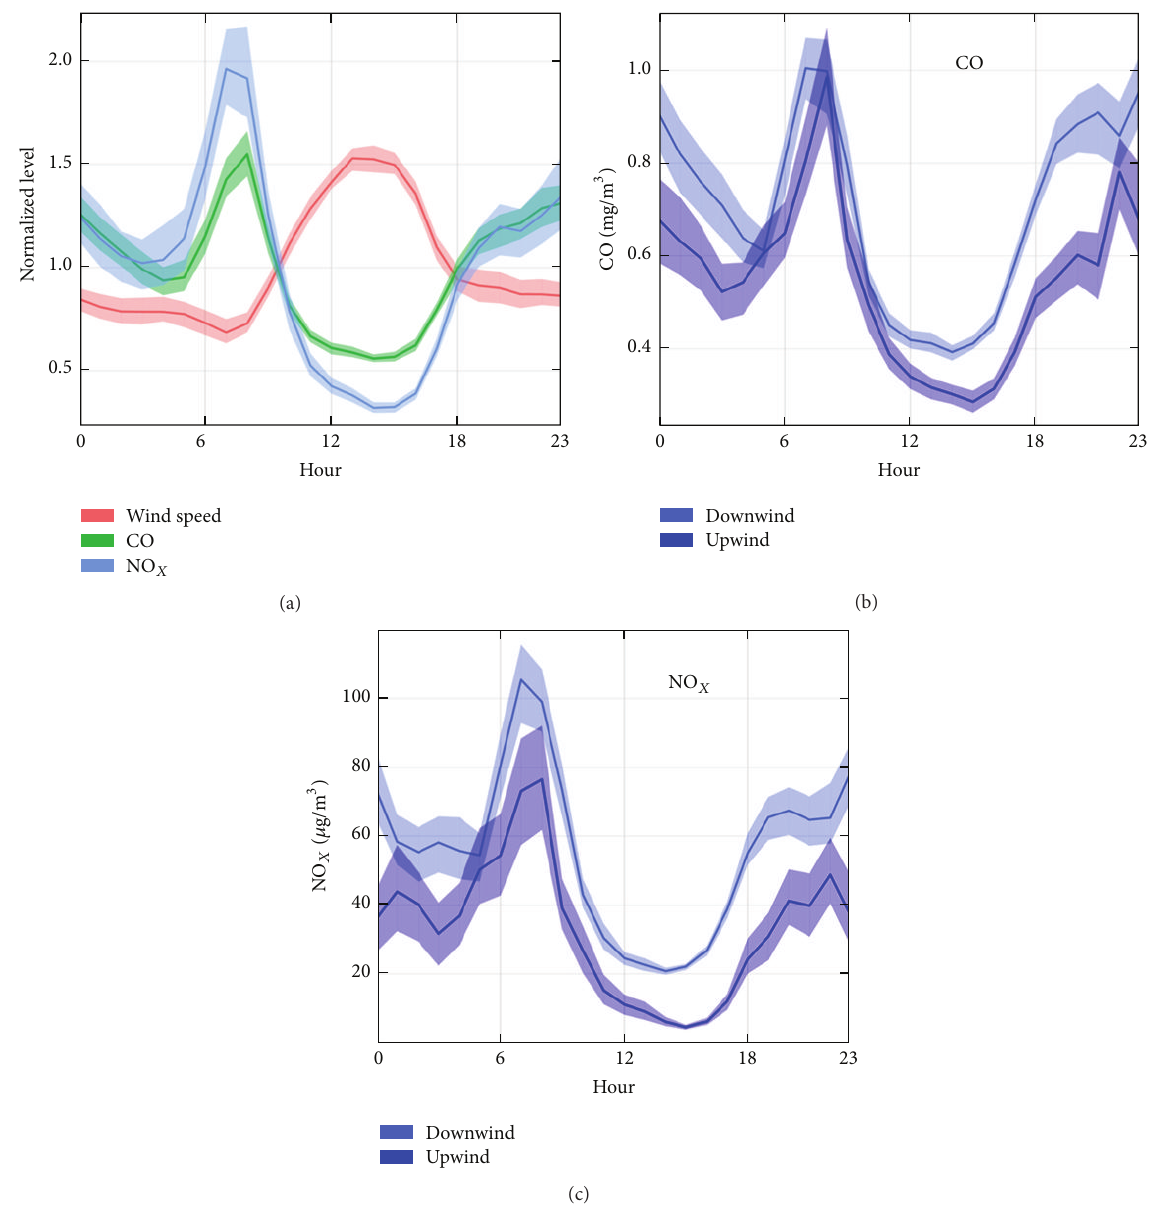
Figure 3: (a) Time variation of hourly average concentration of CO, NO 𝑋 , and wind speed at 25DP (normalized values are presented). (b) Upwind and downwind concentrations of CO at 25DP. (c) Upwind and downwind concentrations of NO 𝑋 at 25DP. Note. The band shows 95 % confidence interval through bootstrap